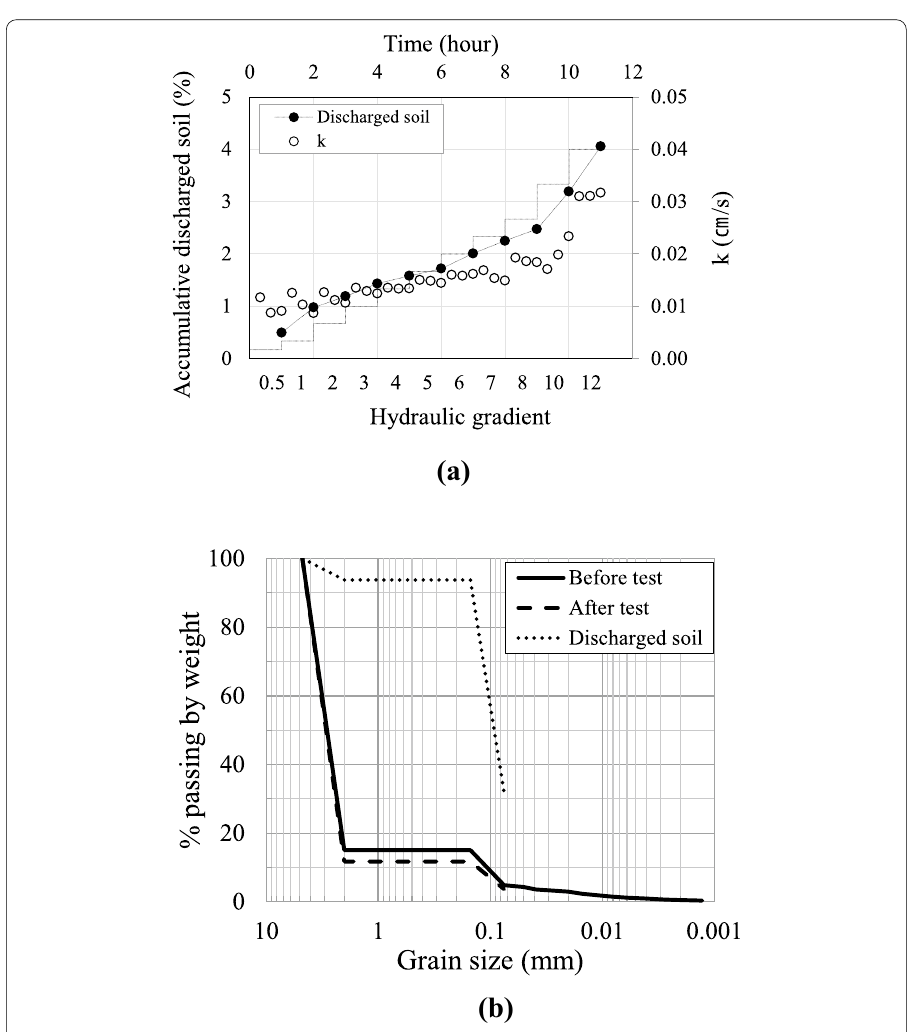
Fig. 3 Short‑term test results of gap‑graded silty sand: a accumulative discharged soil and k ; and b grain size distribution after the